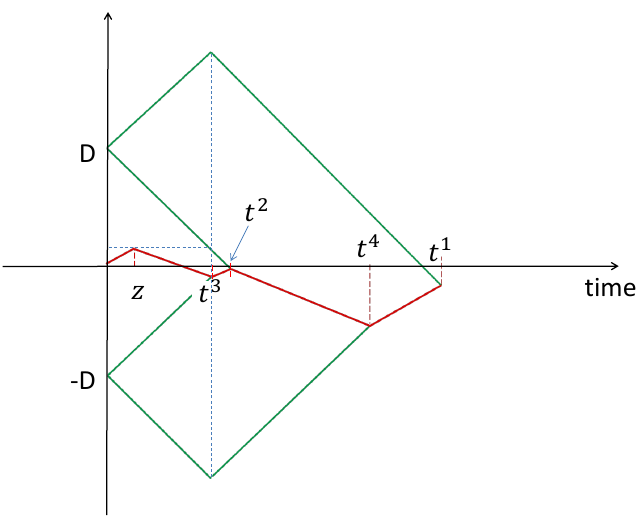
Figure 5. Optimal strategy when player I holds the marker and is the slower player.